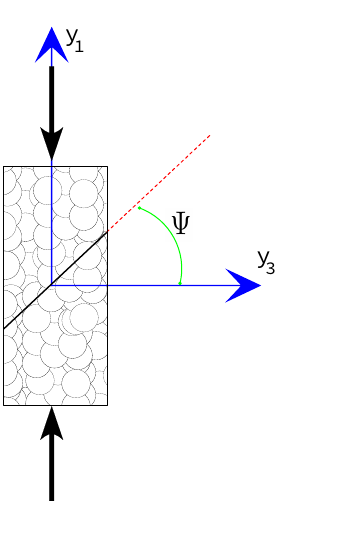
Figure 1. Schematic of a granular aggregate compressed in the direction y 1 , with a shear band formed in the plane y 1 ,y 3 .